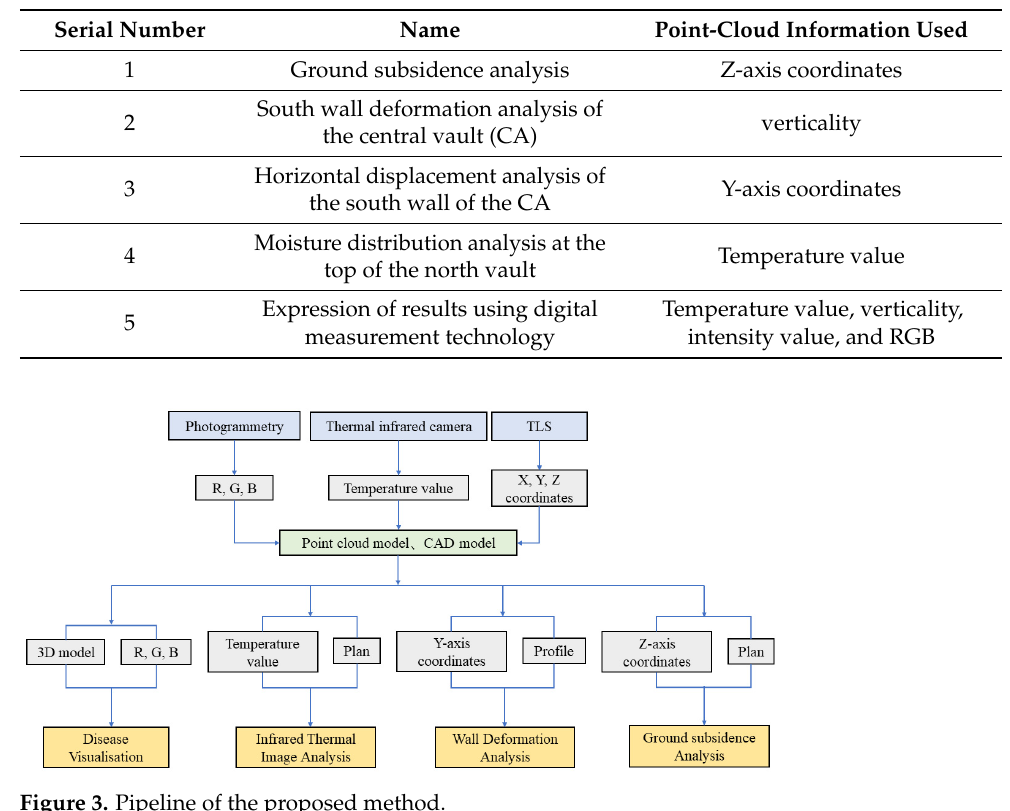
Table 1. Technical data of the thermal infrared camera used in this paper.